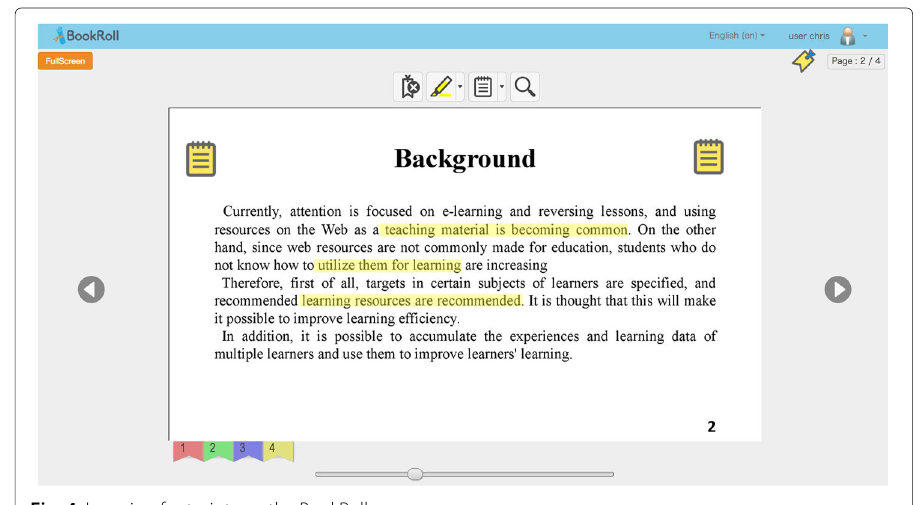
Fig. 4 Learning footprints on the